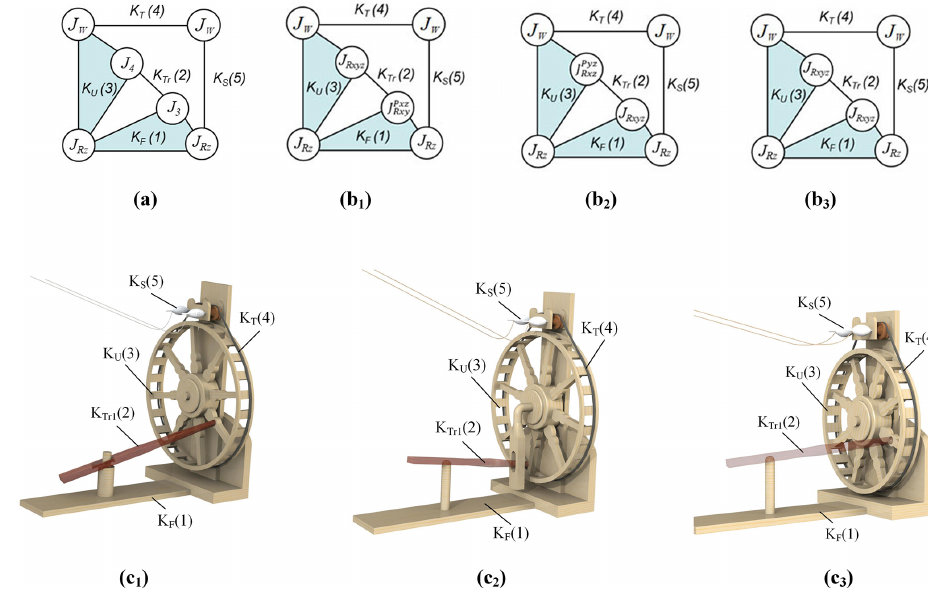
Figure 7. Chains and simulation drawings of treadle spinning wheel (Hsiao and Yan, 2014).